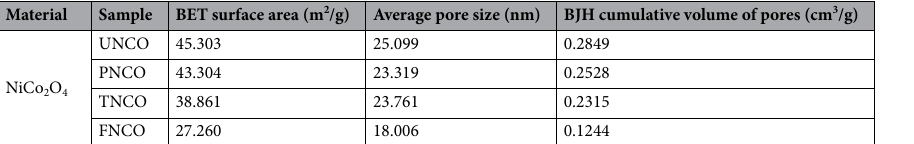
Table 1. Summary of the BET results of the NCO nanomaterials.